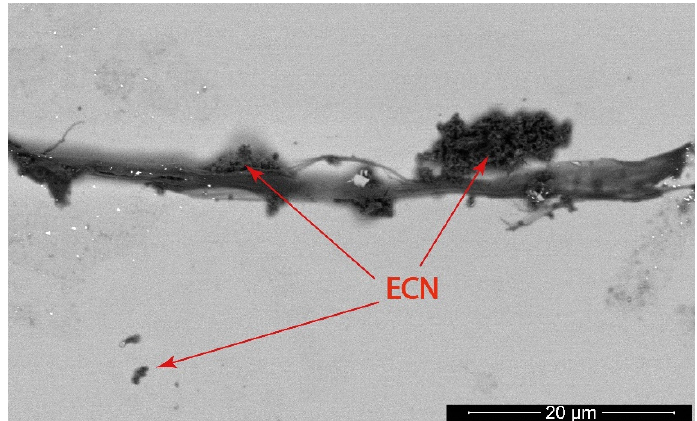
Figure 11. SEM image of released fiber and small ECN particles observed in the MB solution after the experiment with the modified (S4)